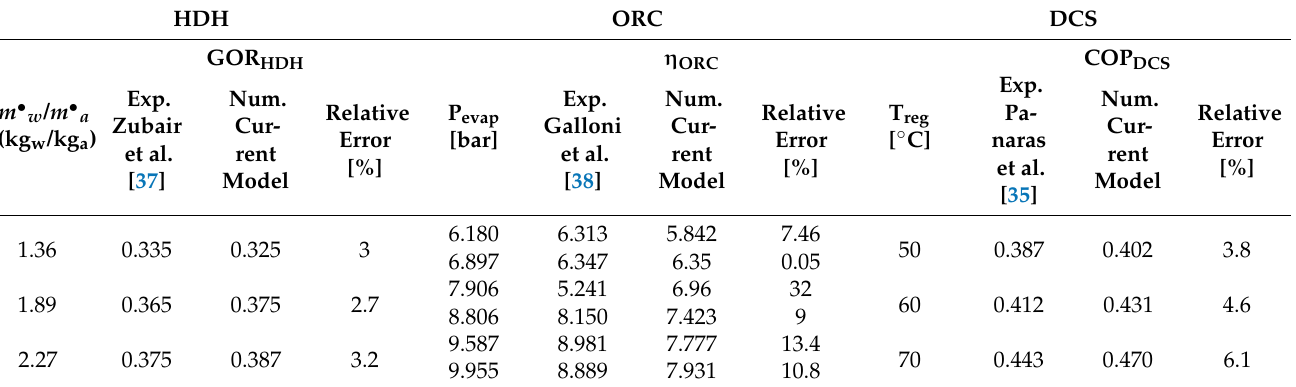
Table 3. Validation of the current model with the published data for HDH, ORC, and DCS systems. HDH ORC